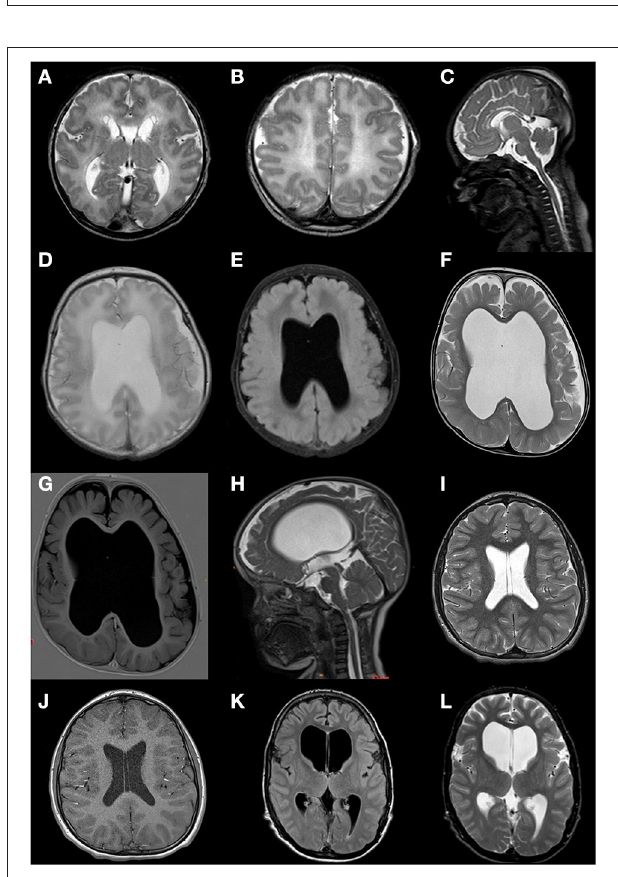
FIGURE 3 | Brain MRI scans of patients 2, 3, 7, and 9. (A–C) Patient 2 at age 2 days; fetal gyral pattern with simplified sulcation, thin corpus callosum with hypoplastic splenium, widened ventricles and cisternae, subependymal pseudocysts, and a cavum septum pellucidum. (D,E) Patient 3 at age 4 days; moderate ventriculomegaly, absence of septum pellucidum, limited volume of the corpus callosum and periventricular white matter, suggestion of cortical malformation of the left temporoparietal region. (F,G) Patient 3 at age 25 months; ventriculomegaly (lateral and third ventricle) and enlarged subarachnoid space due to progressive loss of supratentorial white and gray matter volume; absence of septum pellucidum. (H) Patient 3 at age 28 months; severely enlarged lateral and third ventricle, narrow aqueduct and fourth ventricle, suggesting not only ex vacuo dilatation but dysfunction of cerebrospinal fluid. (I,J) Patient 7 at age 12 years; normal MRI but with persistent cavum septum pellucidum and vacuum vergae. (K,L) Patient 9 at age 15 years; marked ventriculomegaly (especially lateral ventricles). Bones Short limbs were found on clinical examination in eight of nine patients (89%). Skeletal malformations such as trunk–limb disproportion, coxa vara, and scoliosis had been reported in the first NANS-CDG case series (5). Indeed, skeletal